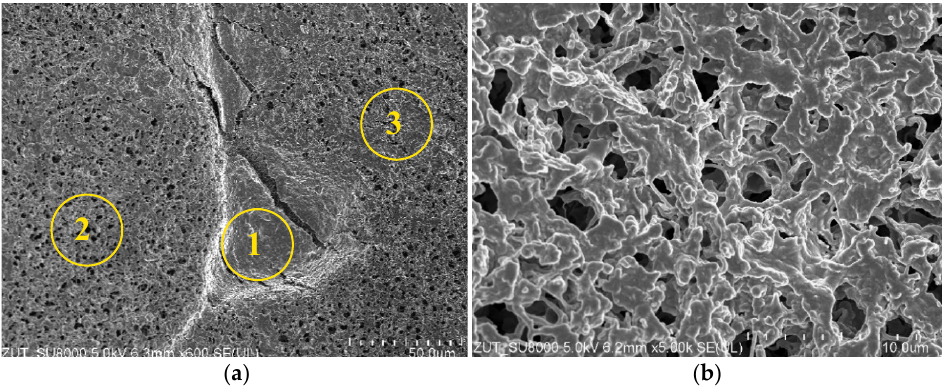
Figure 14. SEM images of the membranes used. The Accurel PP V8/2 HF membrane: ( a ) wall cross-section; ( b ) internal surface; ( c ) external surface. The Accurel PP S6/2 membrane: ( d ) external surface.